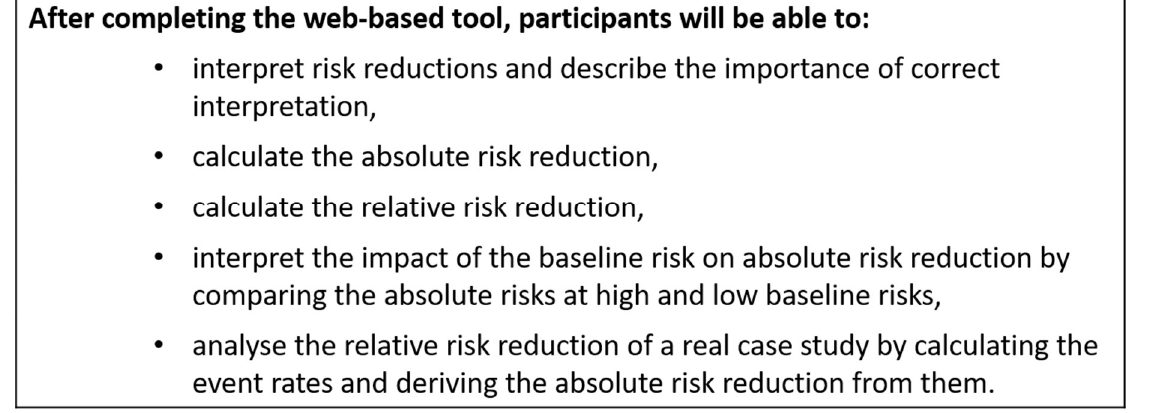
Figure 1. Learning objectives according to Bloom’s Taxonomy.